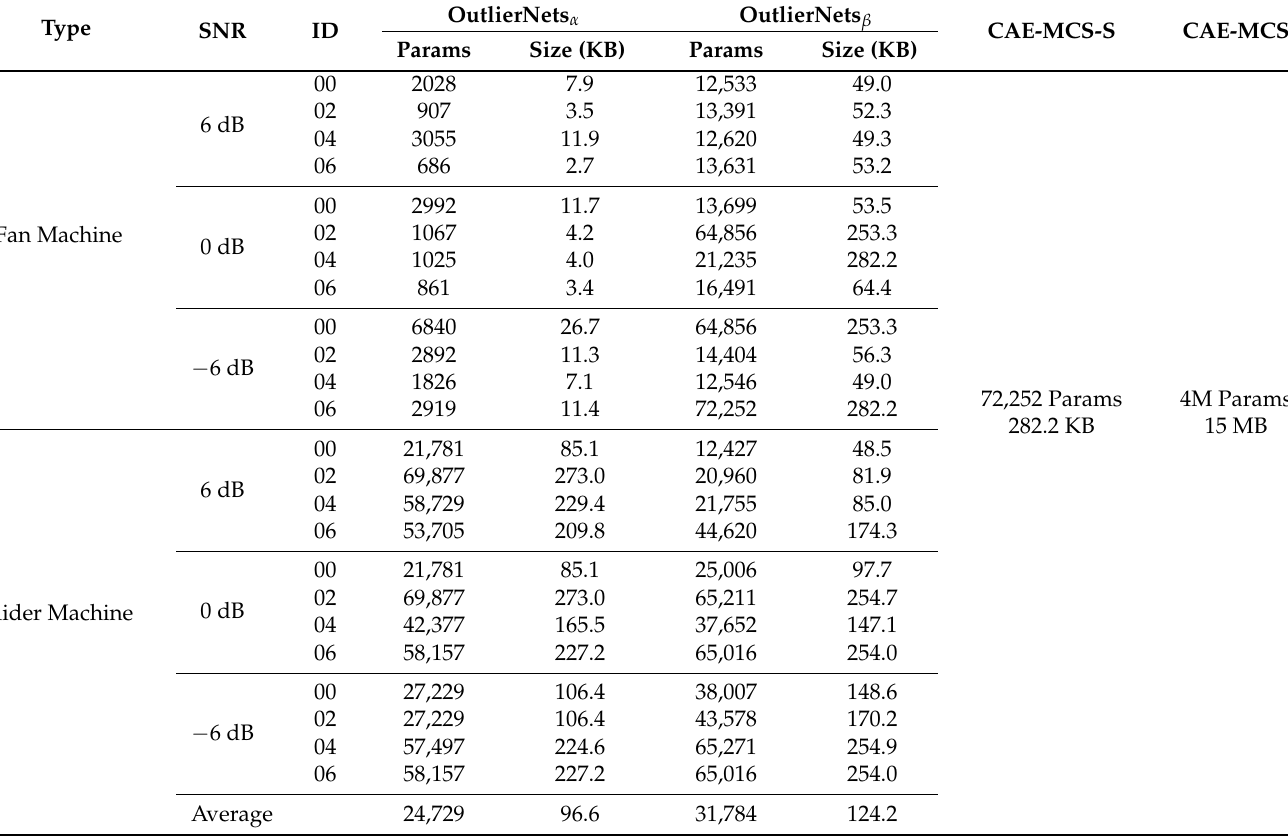
Table 1. Size comparison between OutlierNet architectures with the convolutional autoencoder architecture introduced in [2] (CAE-MCS) as well as a reduced baseline (CAE-MCS-S) in terms of parameter count and memory footprint. Type